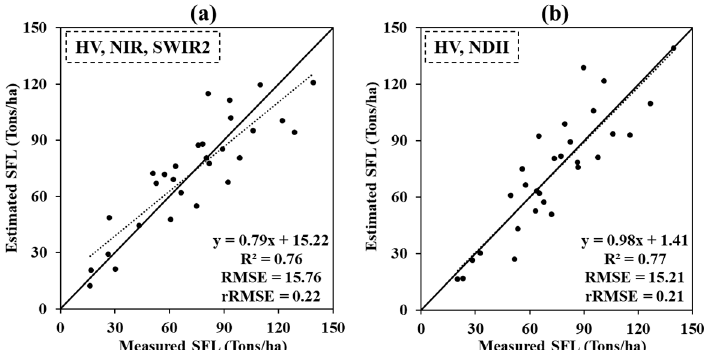
Figure 6. Comparison of SFL estimation using (a) HV and optical bands, and (b) HV and vegetation index (VI).